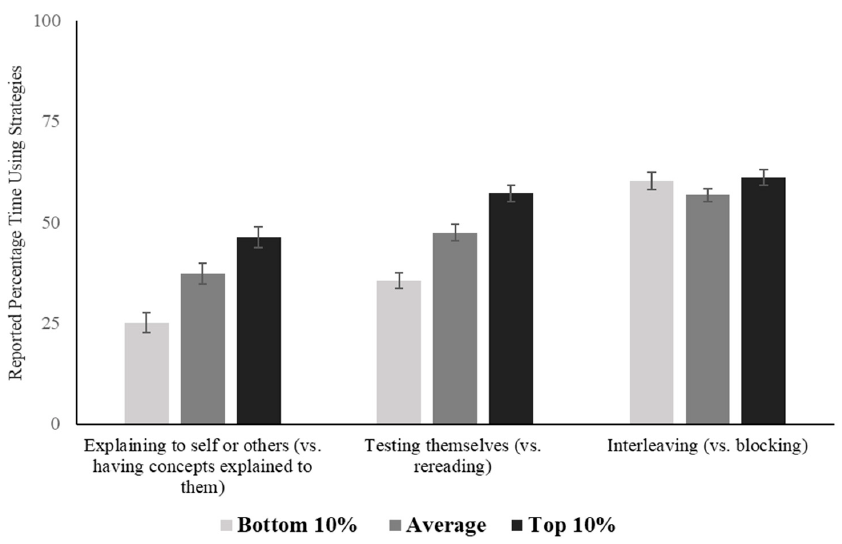
Figure 2. Quality of study: reported percentage of time using the more (vs. less) effective strategy, by condition. Error bars represent one standard error.